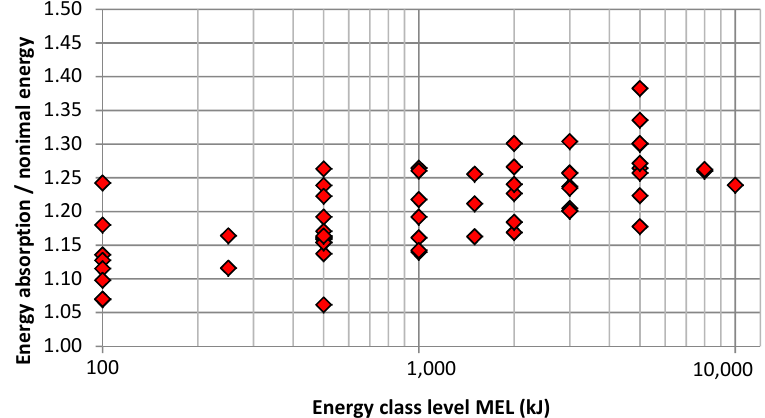
Figure 10. Total absorbed energy in relation to the nominal energy in the individual energy classes (energy class >4500 kJ expanded to show effective impact